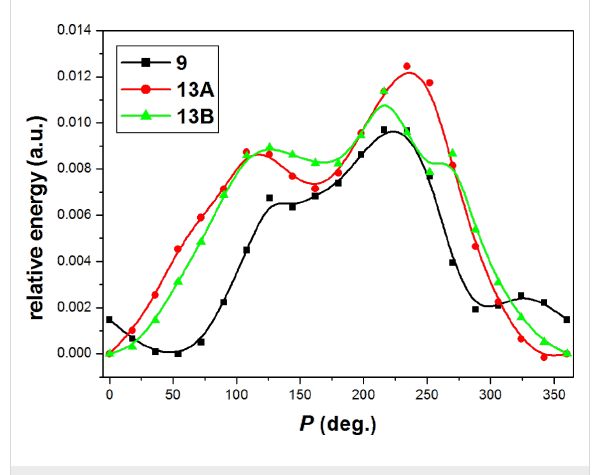
Figure 13: The energy profile of the five-membered pyrrolidine ring pseudorotation for adenine derivatives 9 and 13 .